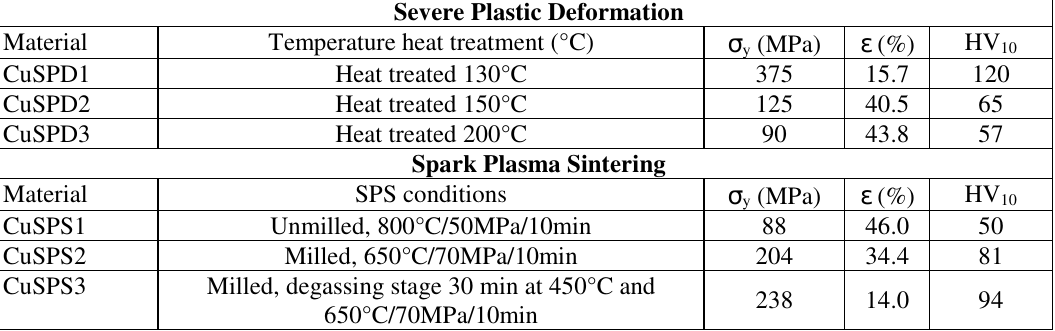
Table 1. Mechanical properties obtained on SPD and SPS samples composed of different